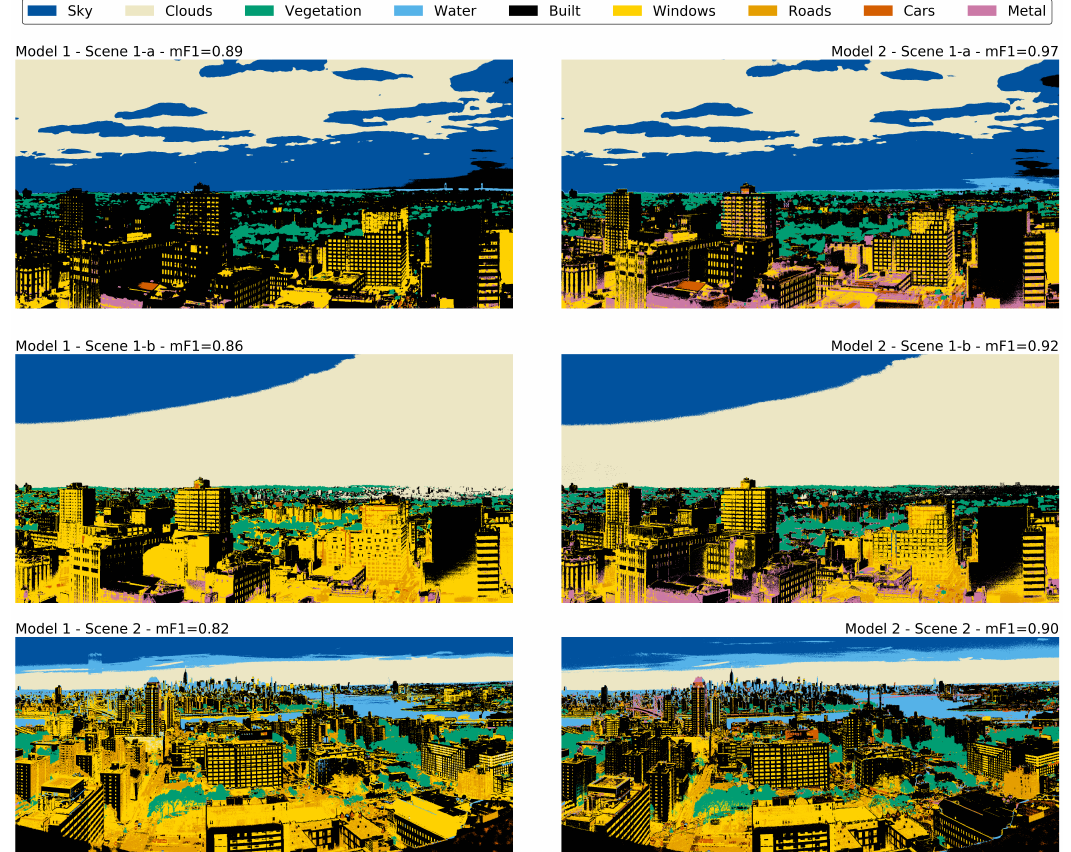
Figure 6. Image segmentation results for Model 1 and Model 2 (see Figure 4) for each of the three scenes in Figure 1. For each model and each scene, the training/testing set consisted of the manually labeled pixels in Figure 3 with Model 2 generating a characteristically larger mean F 1 score for a given scene. In addition, qualitative inspection of unlabeled pixels shows that Model 2 outperforms Model 1 on the segmentation task for each scene. These results are quantified in Table